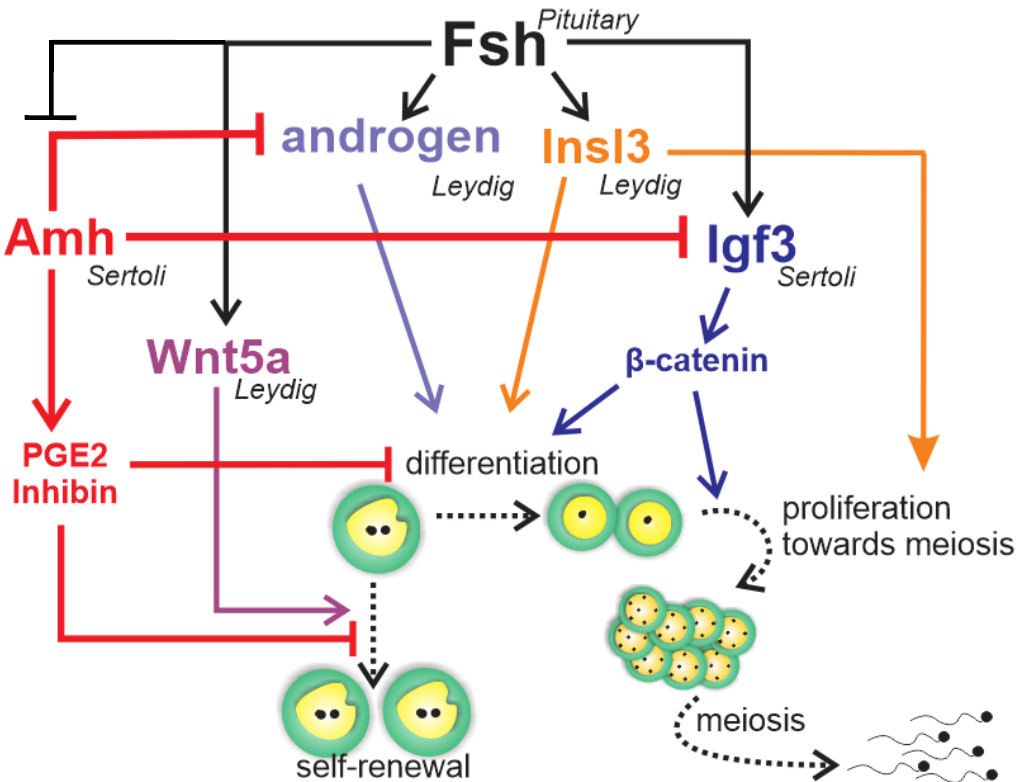
Figure 6. Schematic representation to summarize the regulation of zebrafish spermatogonial phase. Fsh exerts a central role in the zebrafish’s spermatogonial phase by triggering and balancing steroid and growth factor production in testicular somatic cells (Leydig and Sertoli cells). In Leydig cells, Fsh stimulates the production of androgens and Insl3, which are both involved in the spermatogonial differentiation and proliferation. Moreover, Fsh promotes spermatogonial self-renewal by increasing Wnt5a release by Leydig cells. In Sertoli cells, Fsh increases Igf3, which in turn promotes differentiation and proliferation by activating β-catenin signaling in the germ cells. Fsh also down-regulates Amh, a member of the TGF-β (transforming growth factor-beta) superfamily produced by Sertoli cells. Amh, through PGE2 or inhibin, exerts an inhibitory role on spermatogonial self-renewal and germ cell differentiation in the zebrafish testes. To sustain its inhibitory role, Amh also decreases androgen and Igf3 production in Leydig and Sertoli cell, respectively.